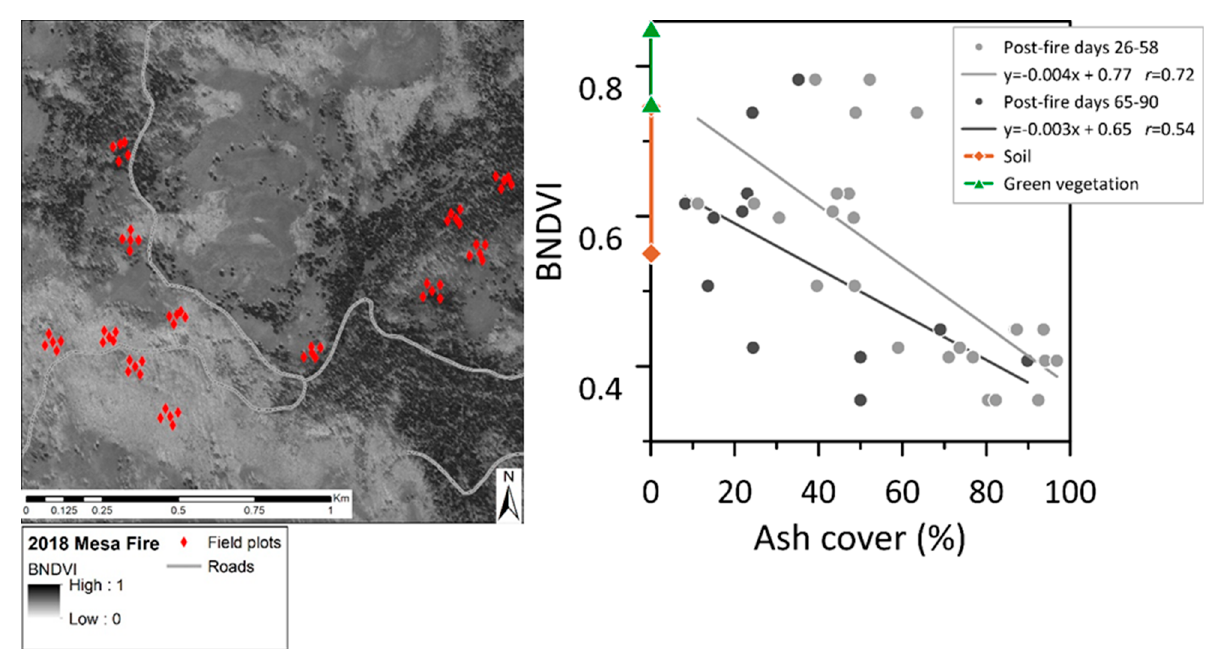
Figure 13. Mesa Fire ash cover from two discrete field sampling periods compared to single-date WorldView-2 BNDVI values. The BNDVI image on the left is from 26 September (post-fire day 62). Darker areas indicate high BNDVI values (i.e., green vegetation), while light gray pixels are areas of ash cover. The graph on the right compares BNDVI and ash cover values with the data subset in the pre and post-WV2 image collection.